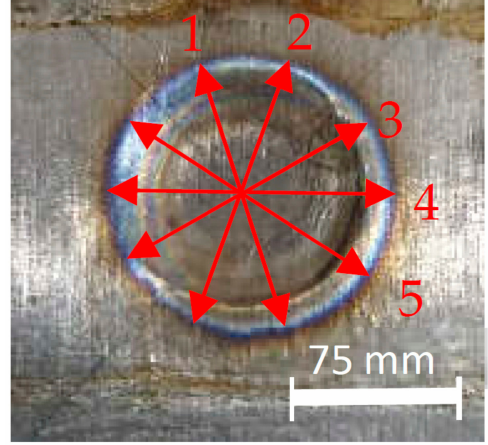
Figure 2. Weld nugget measurement